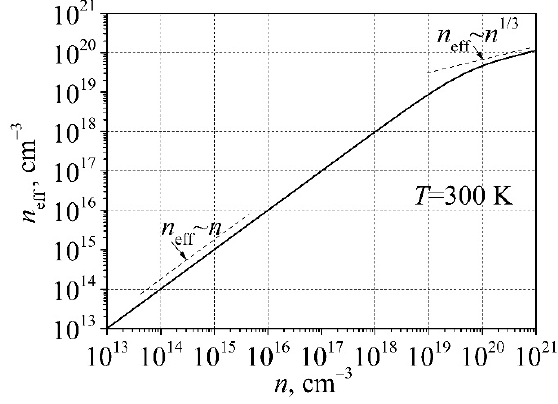
Figure 2. The effective free RM electron density n eff dependence on the total electron density n in the conduction band of phosphorous doped silicon at T = 300 K.